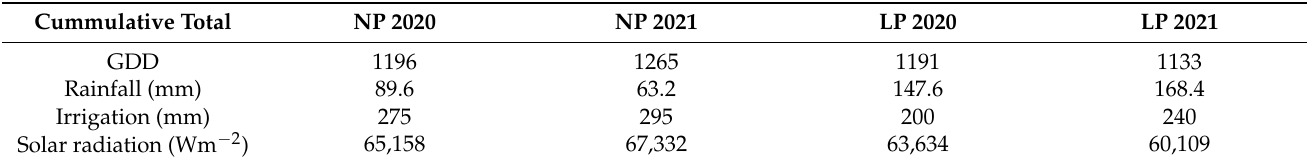
Table 2. Accumulated growing degree days (GDDs) over the sesame growing season (from planting to harvest), accumulated rainfall and irrigation (mm) and accumulated solar radiation (W m − 2 ) for both planting dates and